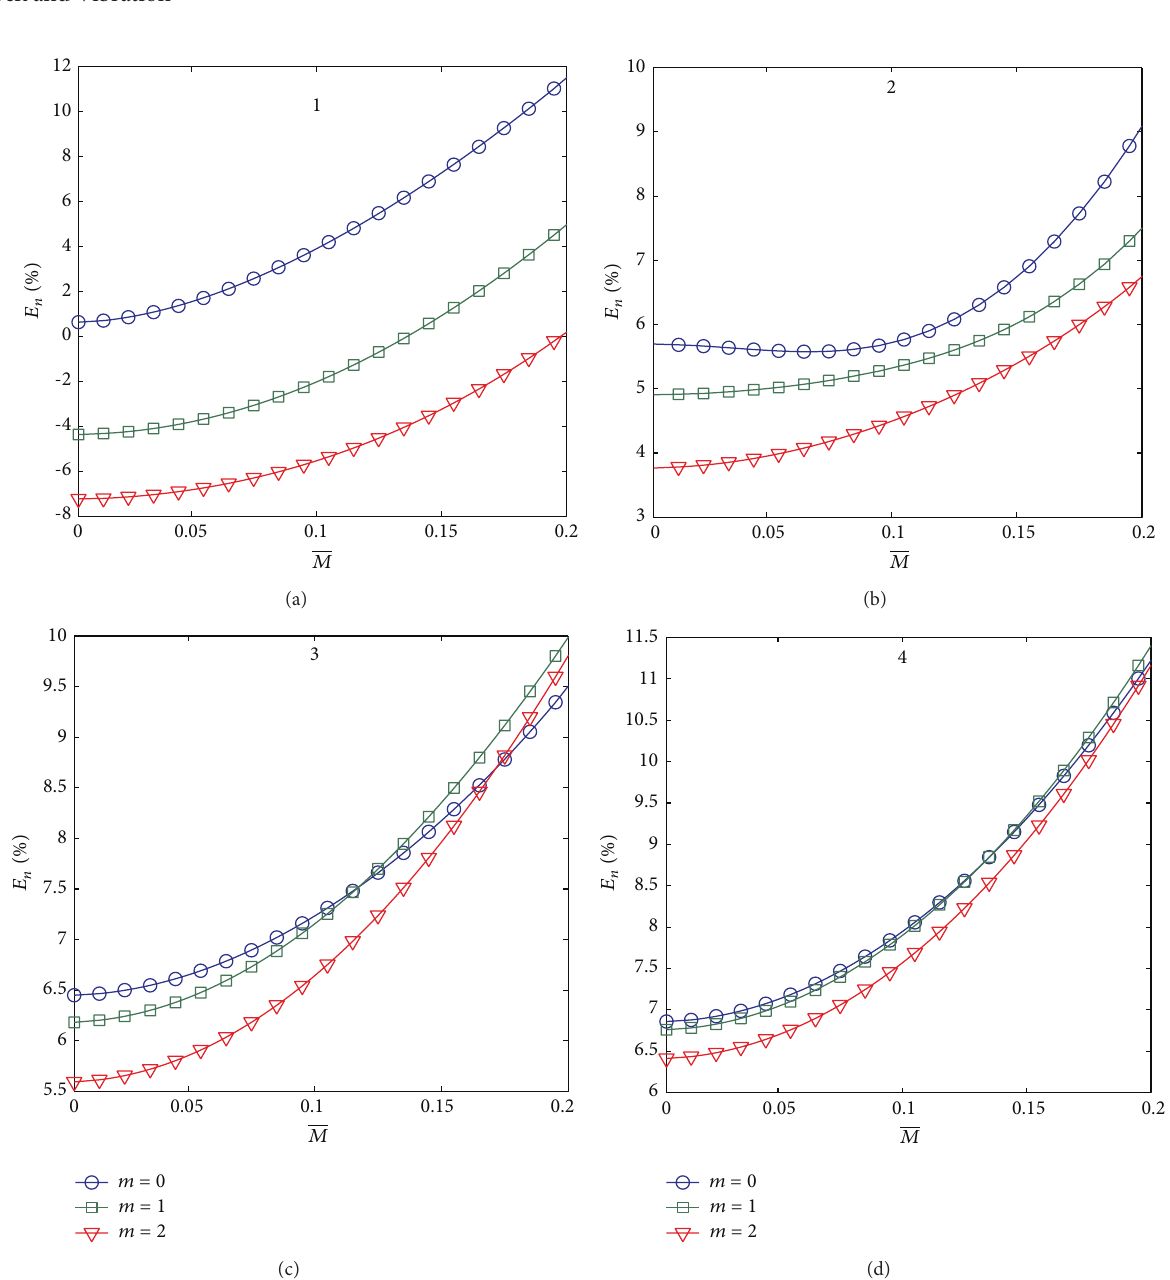
Figure 12: (Color online) Comparison of the measurement errors of the first four axial modes among the three circumferential modes in the turbulent flow confined by a lined-walled